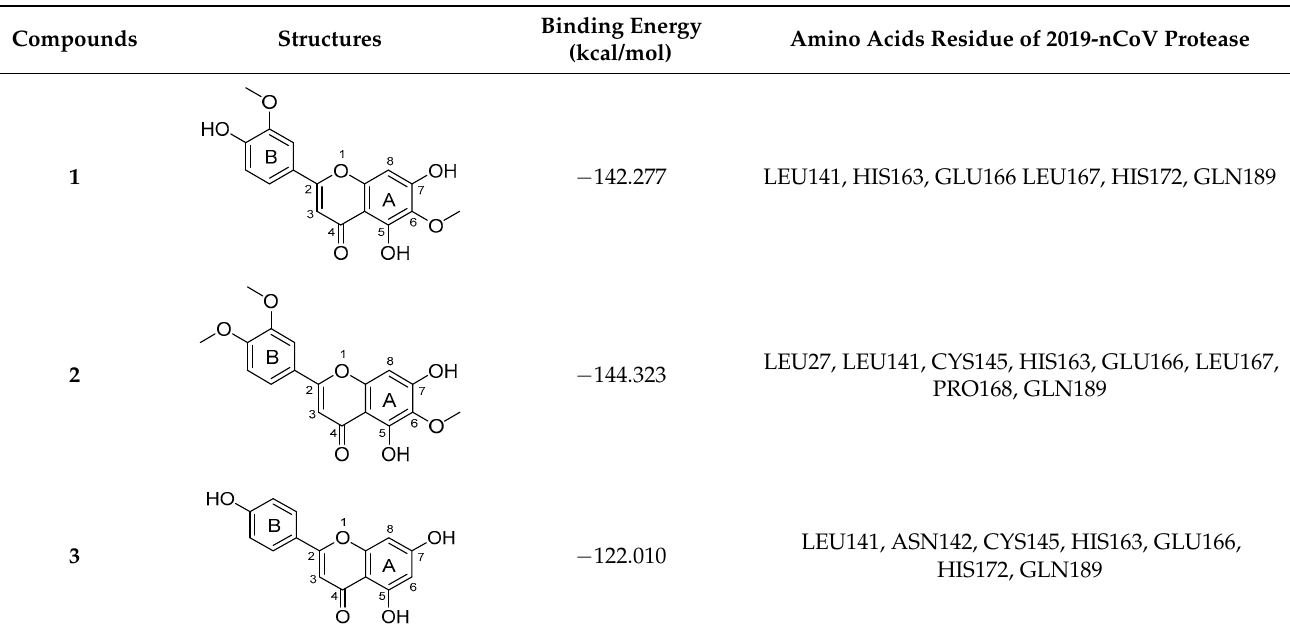
Table 2. Data analysis of the flexible docking of compounds 1 – 6 in the active site of the 2019-nCoV protease receptor.